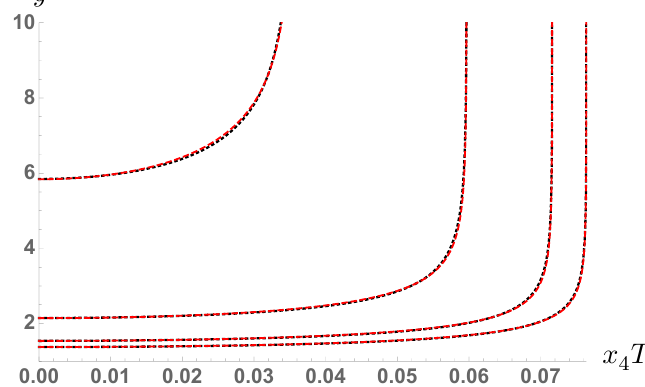
Figure 8 . Comparison of the numerical profiles (red dashed lines) with the variational profiles (black dotted lines) for four cases: ˜ L = 0 . 64 , ˜ L = 0 . 6 , ˜ L = 0 . 5 and ˜ L = 0 . 3 . The lines are hardly distinguishable, showing that the variational profile is a very good approximation to the exact